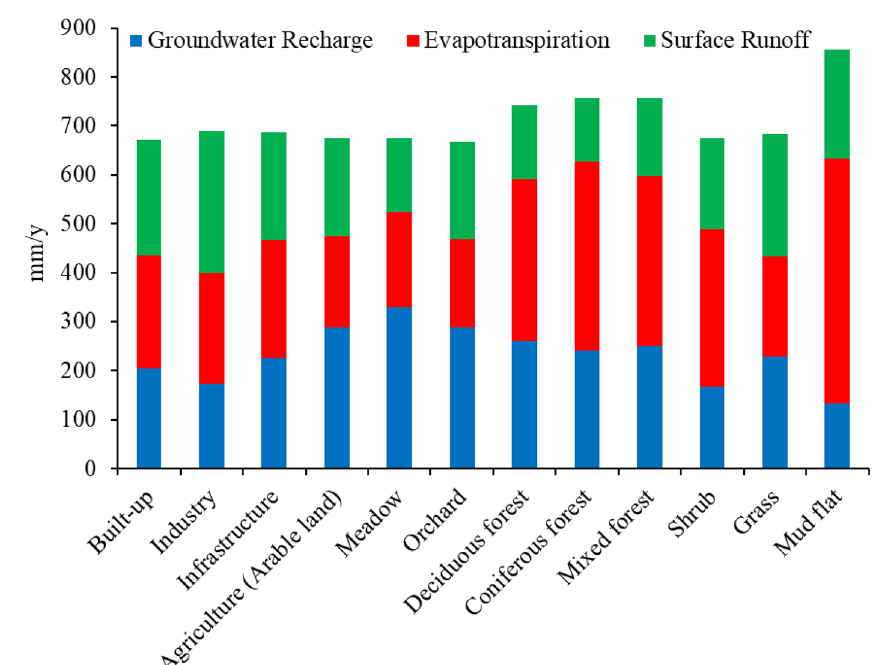
Figure 9. Average annual groundwater recharge, surface runoff and evapotranspiration as a function of LULC in